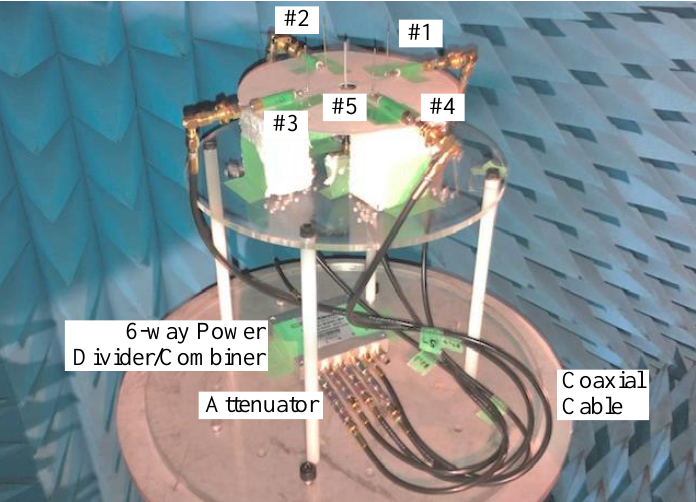
Figure 16. Fabricated antenna with a beamforming network.